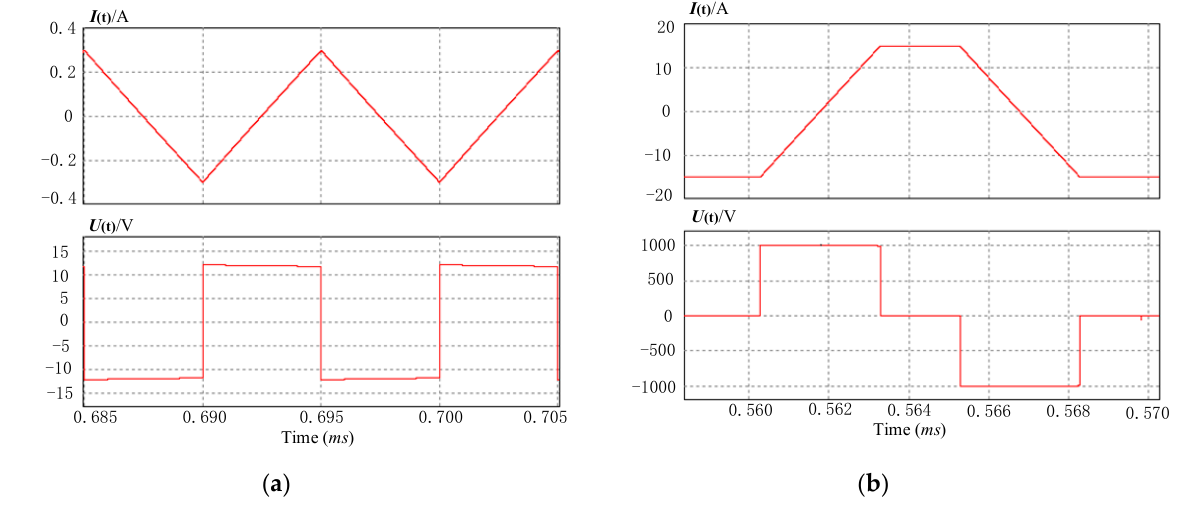
Figure 10. Waveforms of the output current and voltage, 100 KHz. ( a ) Traditional full-bridge circuit; ( b ) Constant current and voltage clamping control